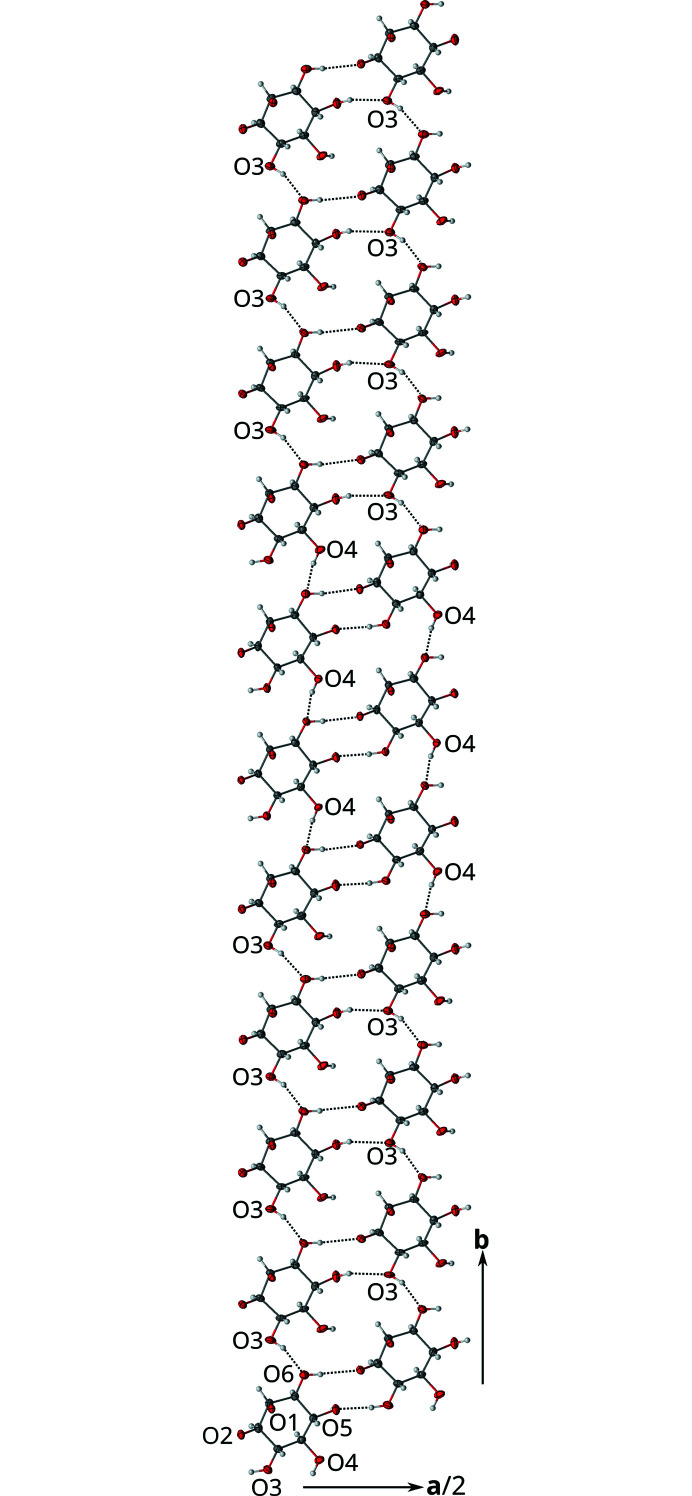
View of an I half-layer projected on the layer plane (001) showing the characteristic (left) 3333444333 and (right) 3334443333 succession of chain orientations. Atom color codes as in Fig. 4 ▸.